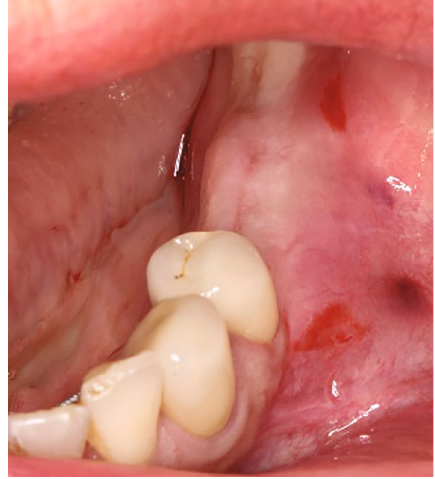
Figure 1: The initial clinical